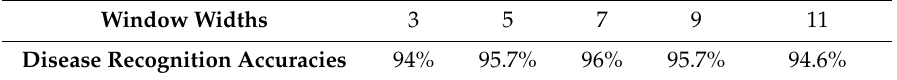
Table 4. The results of ECR-based disease recognition method under different window widths.